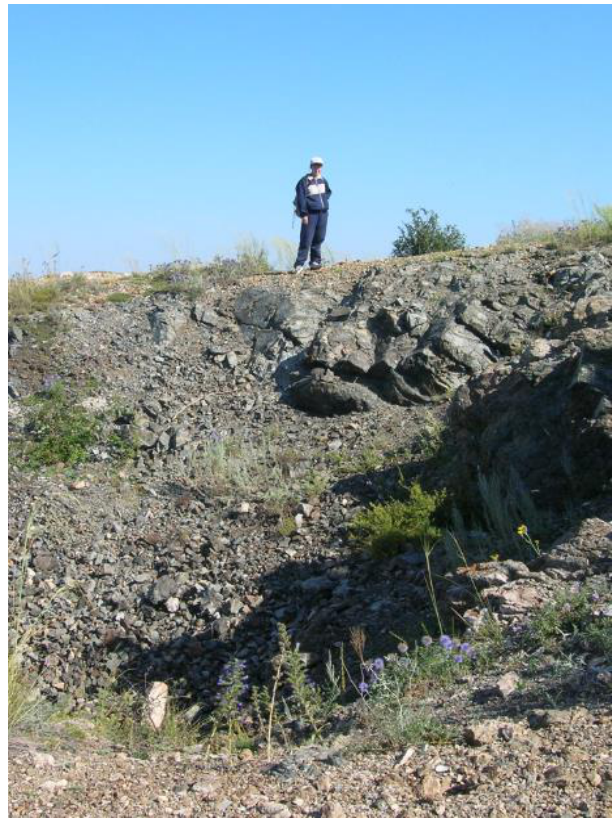
Figure 2. Melnichnye Sopki geosite.